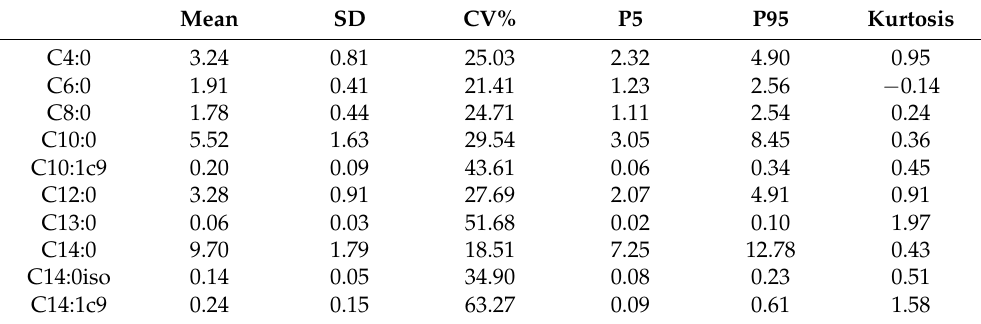
Table 1. Descriptive statistics for individual milk fatty acids (g/100 g of total lipids) (FA; n =